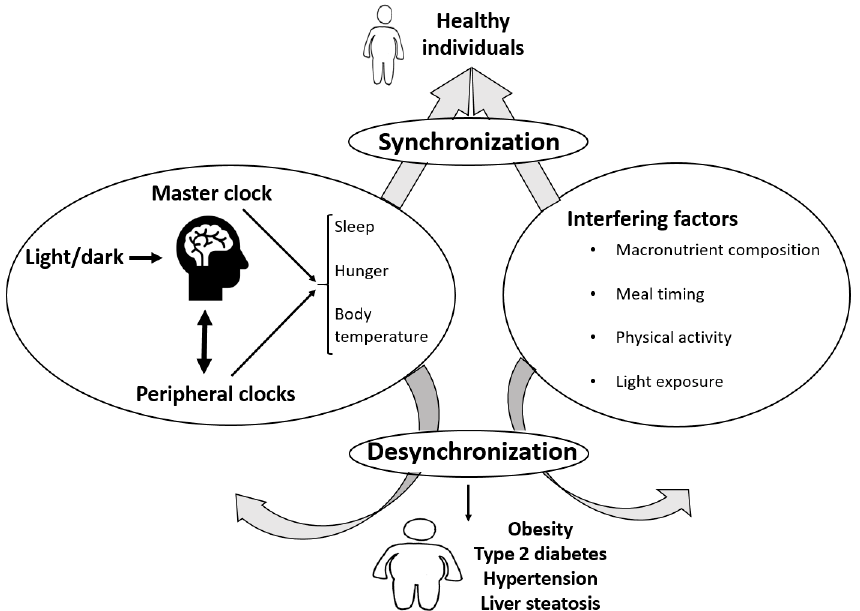
Figure 2. Human circadian rhythm: link between circadian clocks and environmental factors. The central clock and peripheral clocks regulate many physiological functions such as sleep, hunger and control of body temperature. Factors that interfere with the expected demand, including macronutrient composition, meal timing, physical activity and light exposure, may disrupt the physiological harmony between predicted and actual behavior. Such a desynchronization may favor the development of obesity and its